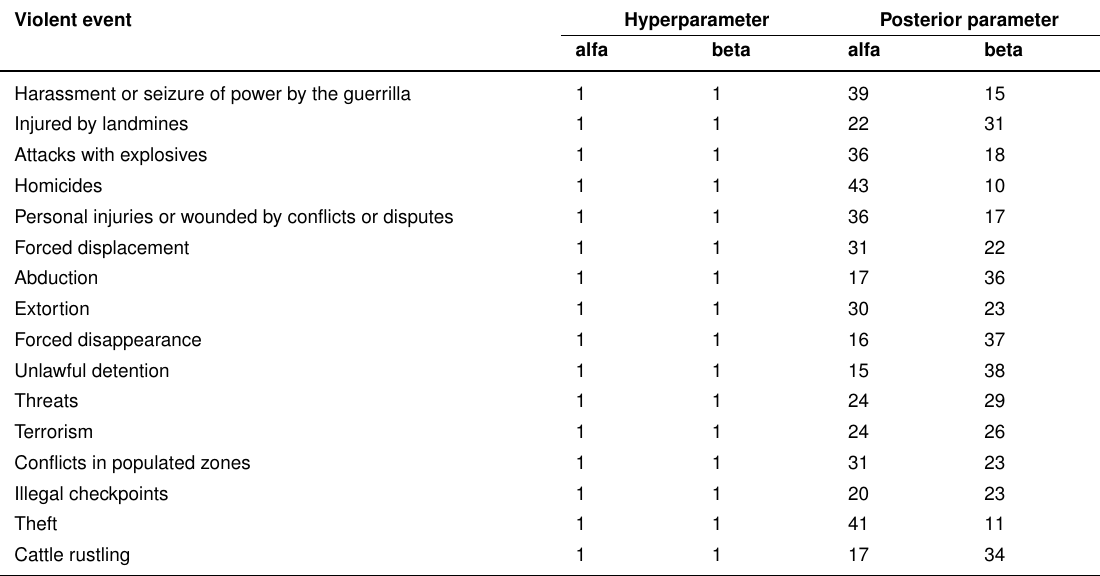
Table A3. Hyperparameters and parameters of Beta prior and posterior distributions considered in the estimation process for the proportions of violent events remembered by Miranda’s inhabitants during the period 2010-2013. Violent